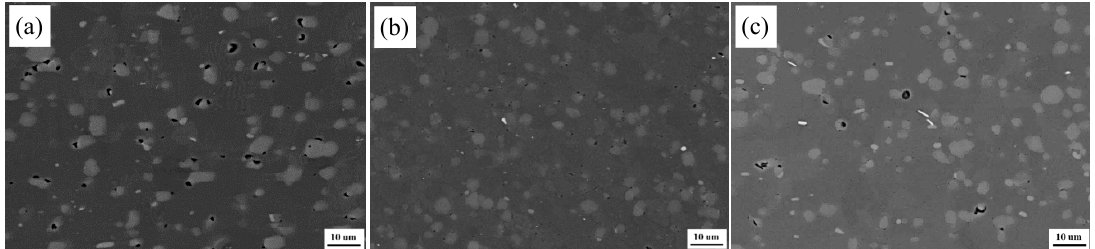
Figure 8. SEM images at the NZs of FSW joints under different states: ( a ) T1; ( b ) T4; ( c ) T6.